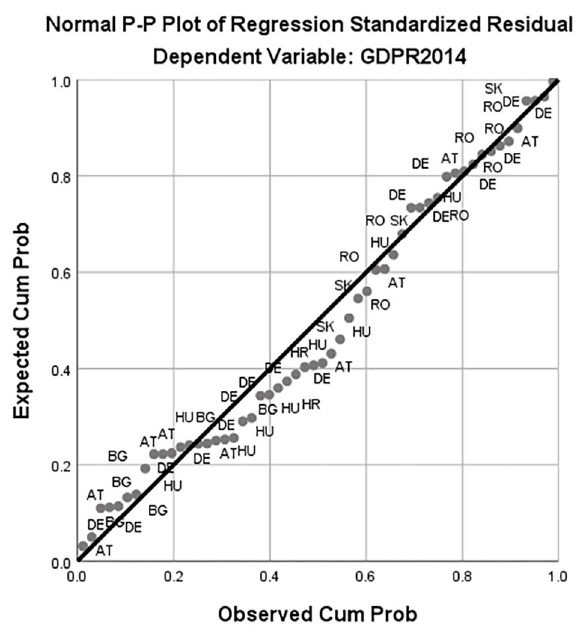
Figure 3. P-P Plot for sustainable development of EUSDR in